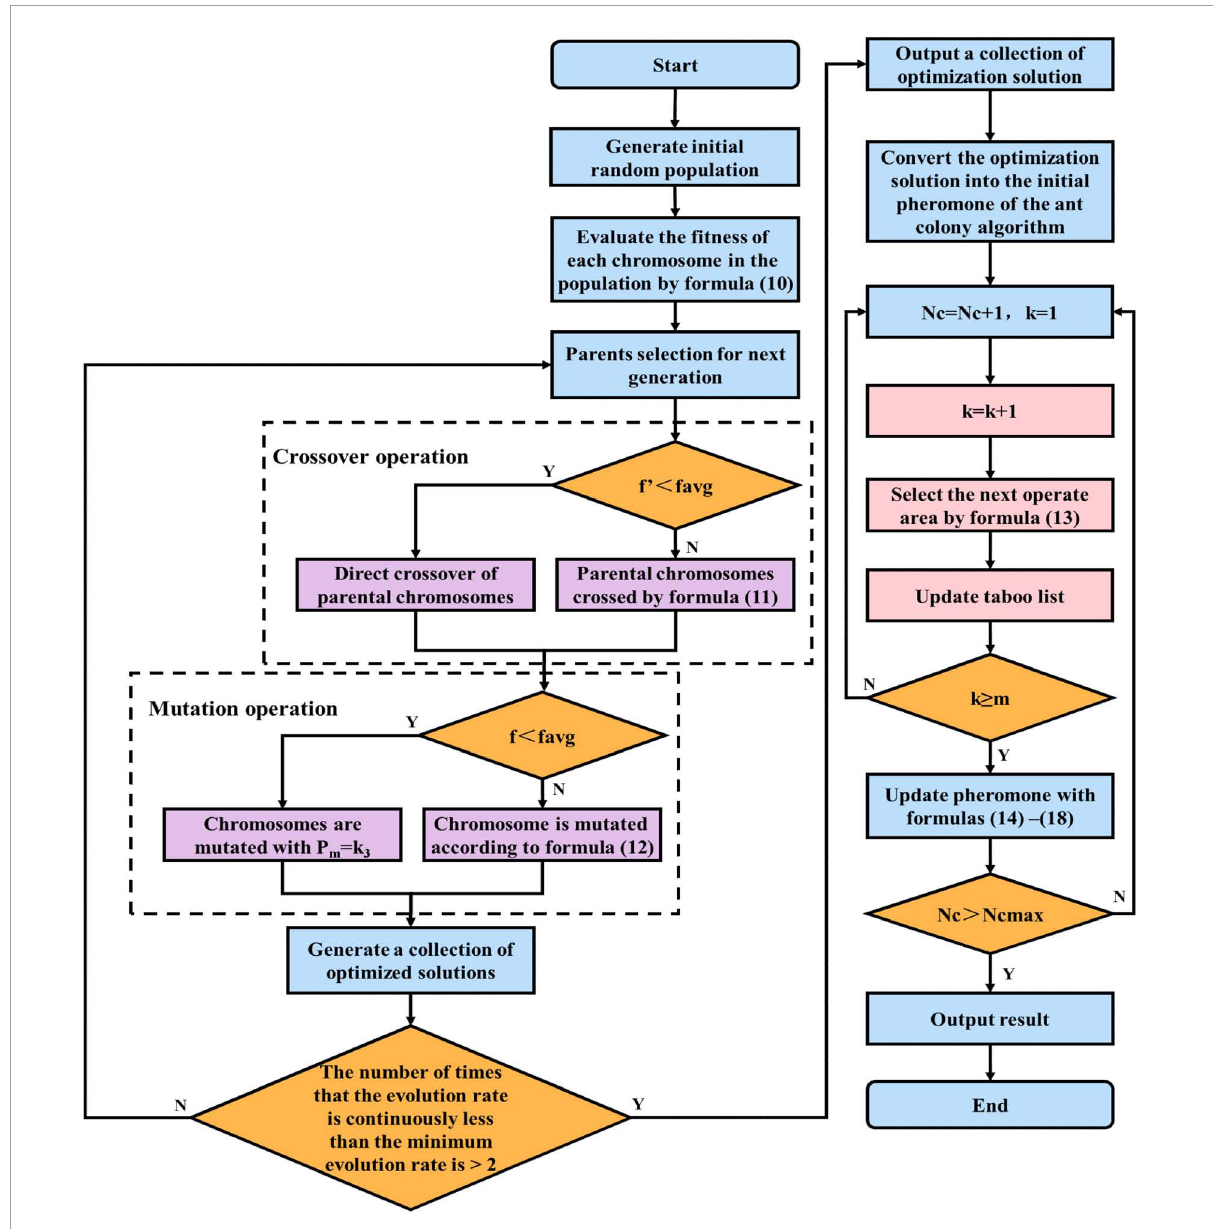
FIGURE6 Search flow chart of